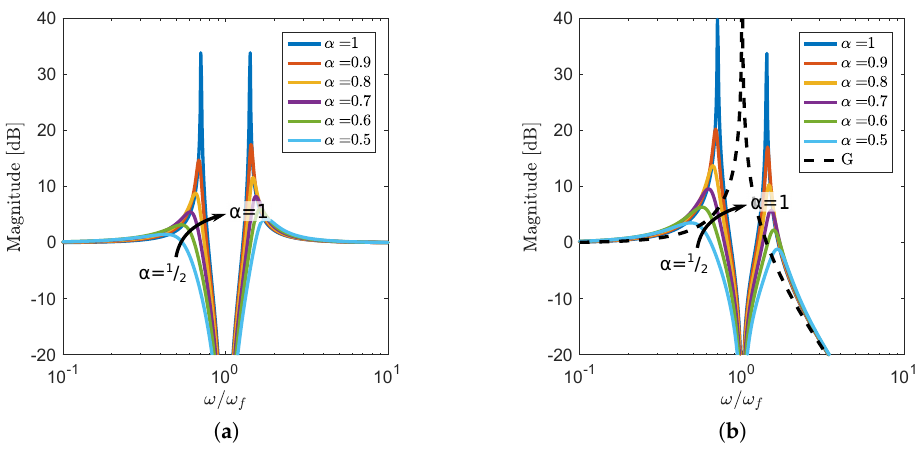
Figure 4. Sensitivity function S ( a ) and closed-loop frequency response T ( b ) for a lightly damped plant and marginally stable fractional-order attenuators with different α . All other parameters are constant, ω f = ω n .